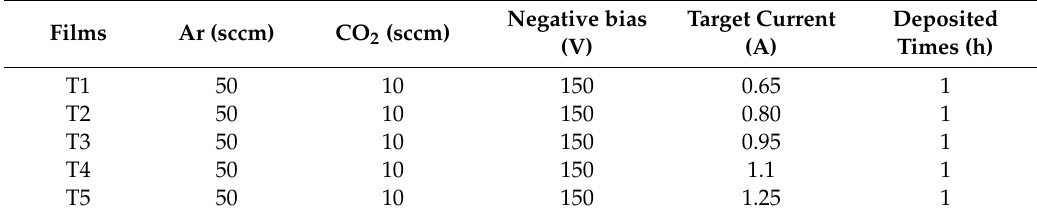
Table 1. The deposition parameters for the TiC x O y